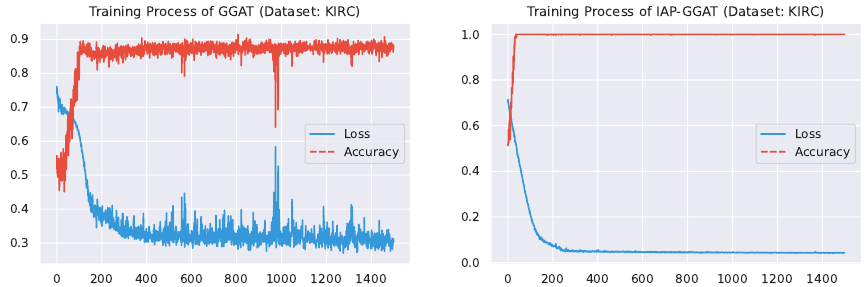
Figure 9. Training process of GGAT and IAP-GGAT on KIRC dataset.